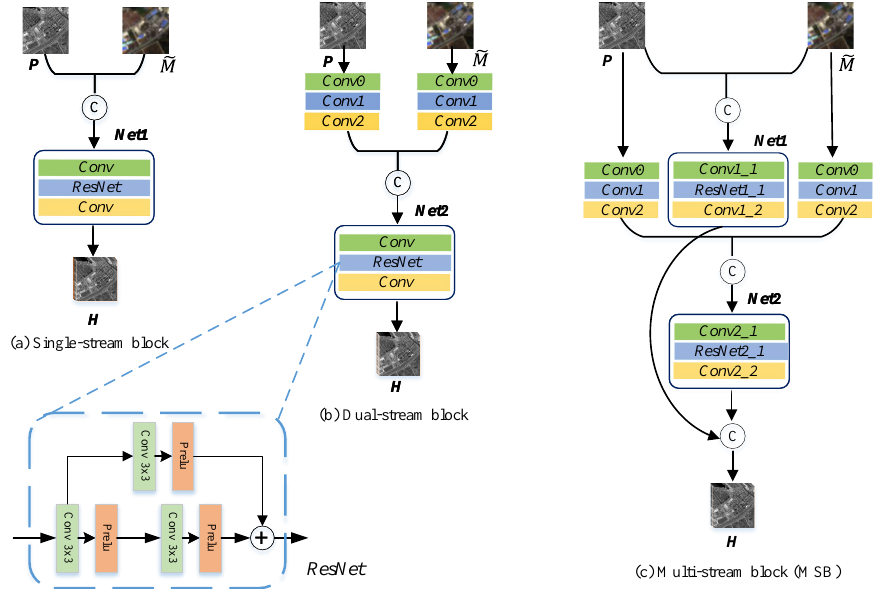
Figure 2. A comparison of three different stream-based fusion blocks. ( a ) The single-stream block is based on the concatenation of the MS and PAN images. ( b ) The dual-stream block separately inputs the two source images to the feature extraction network. ( c ) The multi-stream block (MSB) exploits three streams to separately extract the features from the PAN, the MS, and the concatenation of the two inputs (i.e., MS and PAN). © refers to the concatenation